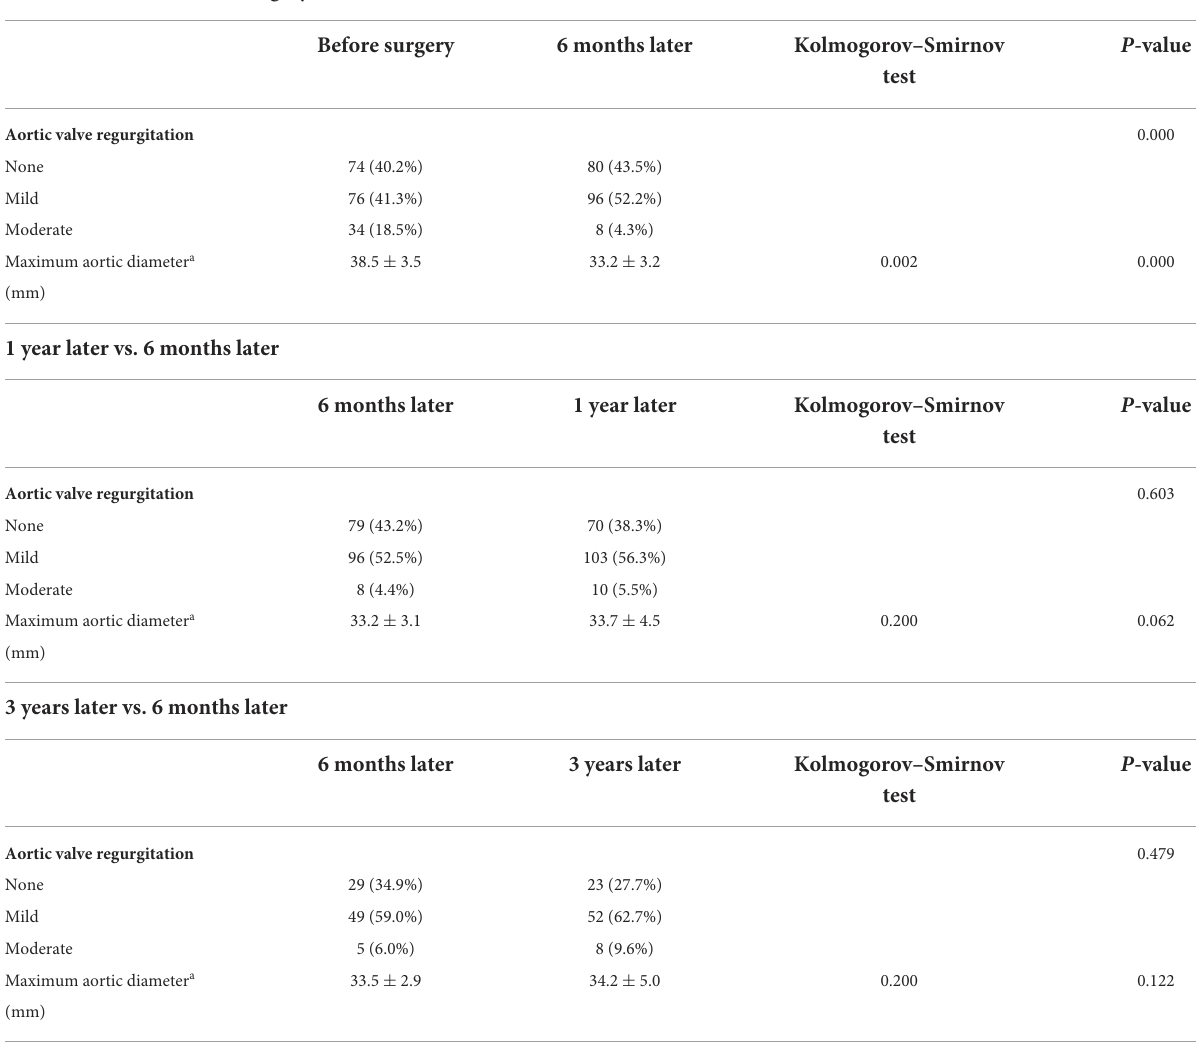
TABLE 4 Aortic valve regurgitation and diameter of the aortic root of patients in the repair group. 6 months later vs. before